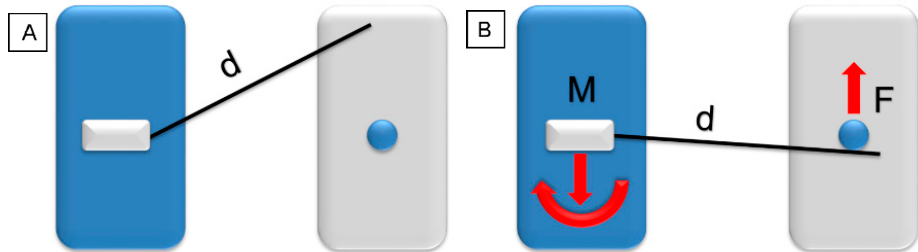
Figure 2. Model of a statically determined force system (blue: anchorage unit with cantilever; grey: point of application). ( A ) Cantilever in a neutral position, length (d). ( B ) Activated cantilever a single force (F), and a force and a moment (M) on the other side (red arrows).